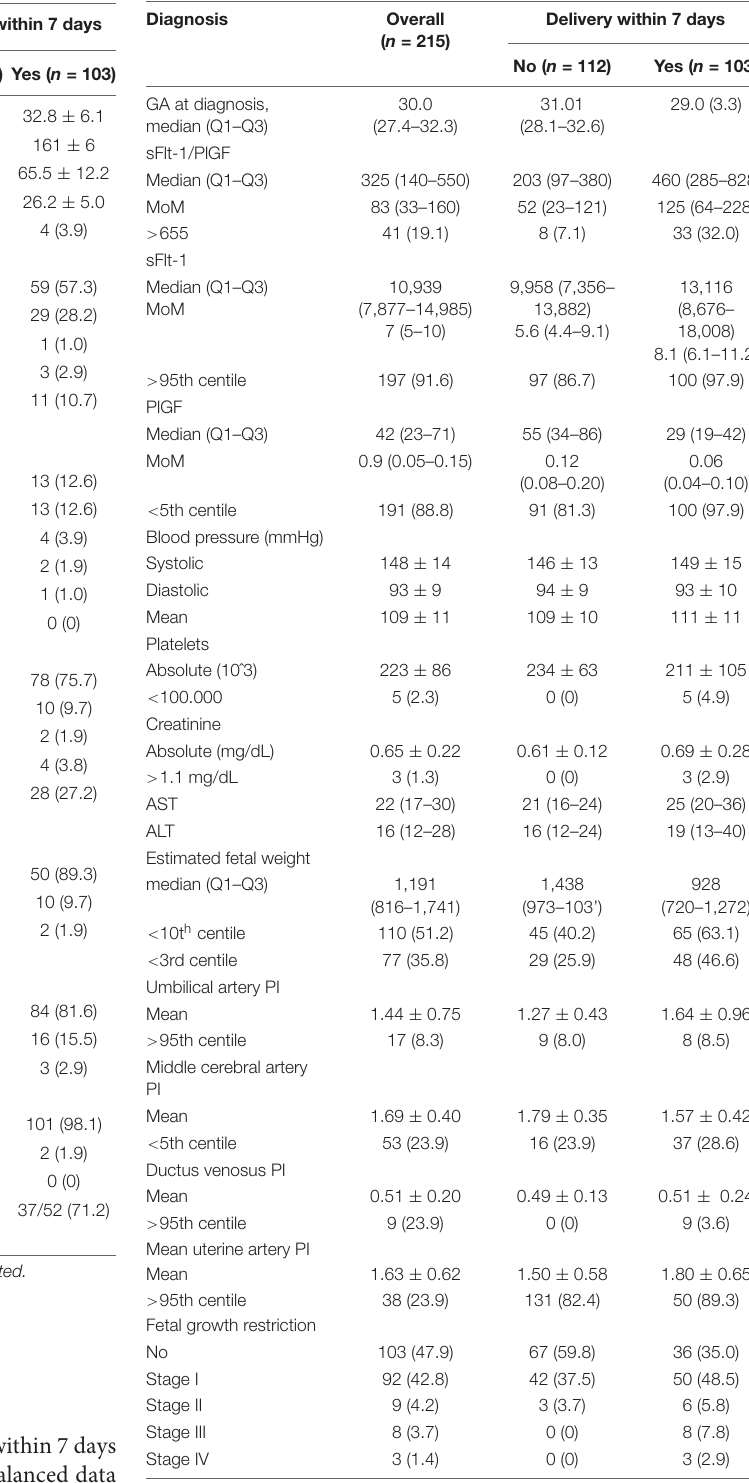
TABLE 2 | Diagnosis characteristics of the study population stratified by the presence of preeclampsia complications within 7 days of